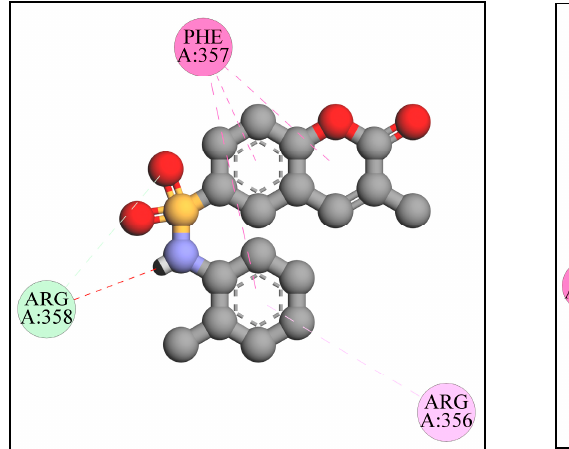
Table 1. % inhibition of standard and synthesized compounds along with IC 50 ( μ M) values ( n = 3, mean ± SD).